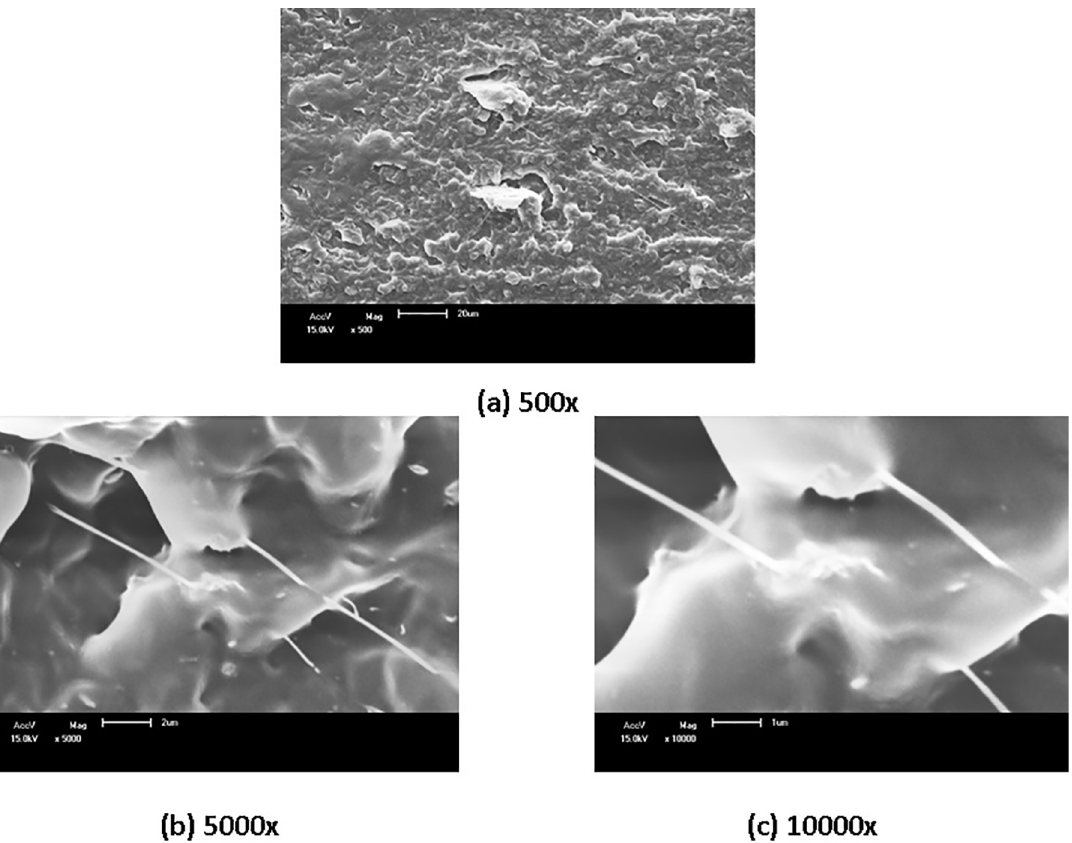
Figure 10. SEM images of PCL/PCL-g-MA/CLNa in different magnifications, Figure 10a 500x, Figure 10b 5000x and Figure 10c